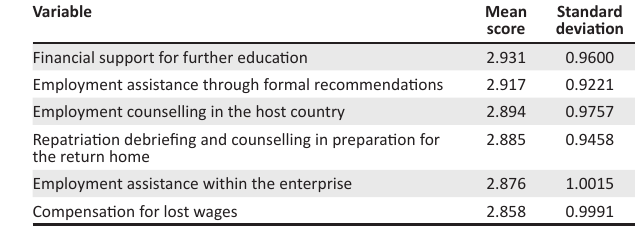
TABLE 9: Mean scores for vocational support required.